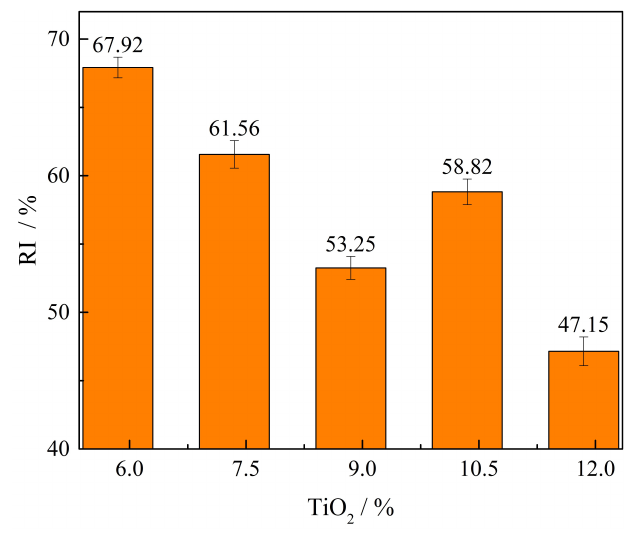
Figure 10. RI of CVTM sinters with different TiO 2 content.